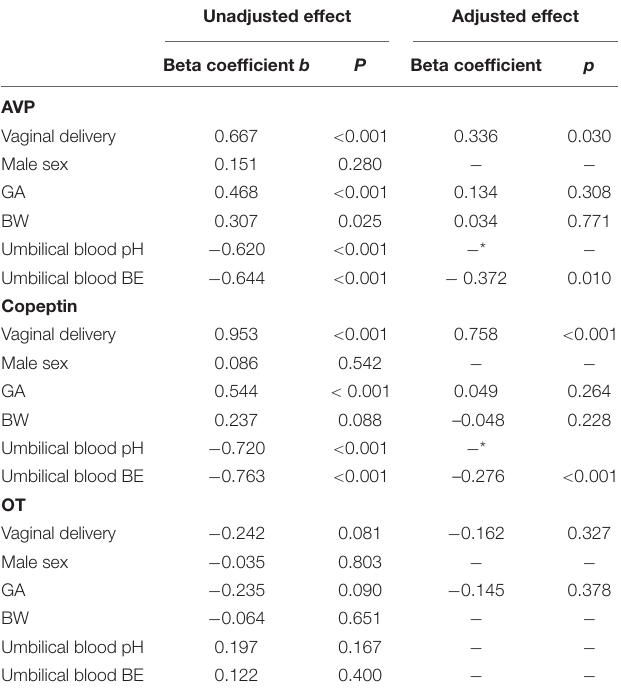
TABLE 2 | Effect of various parameters on arterial umbilical cord blood levels of arginine vasopressin, copeptin, and oxytocin. Unadjusted